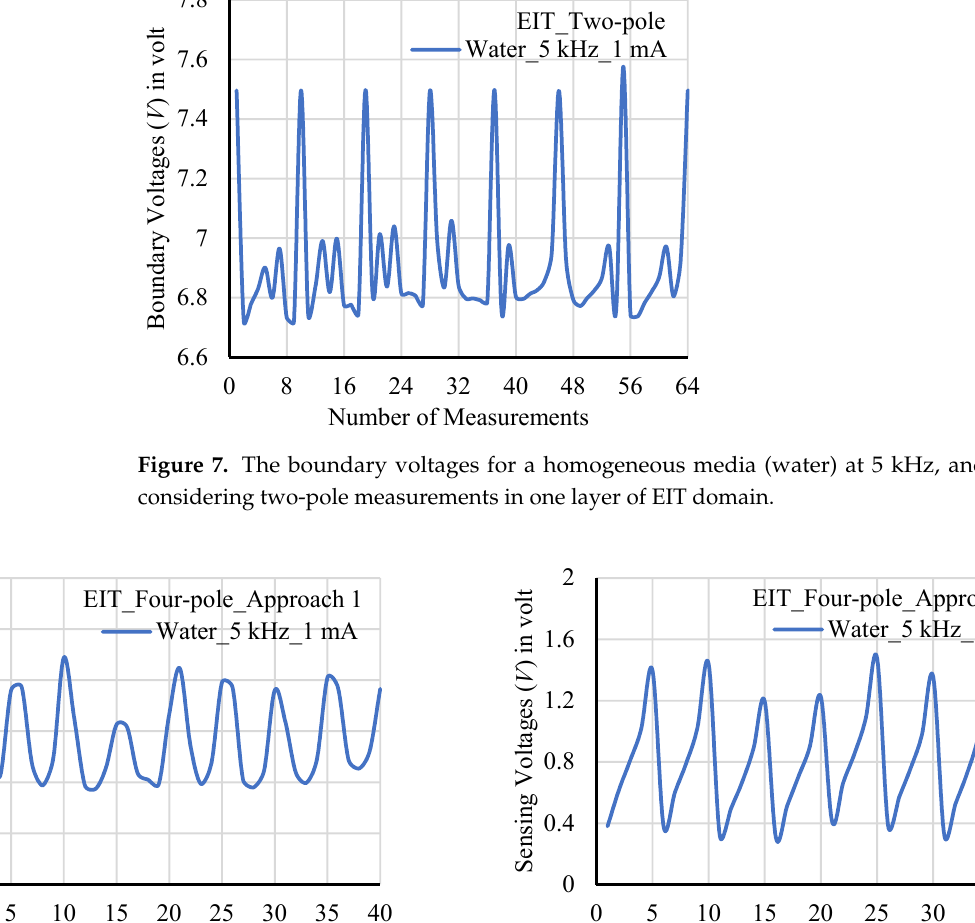
Figure 7. The boundary voltages for a homogeneous media (water) at 5 kHz, and 1 mA signal considering two-pole measurements in one layer of EIT domain.